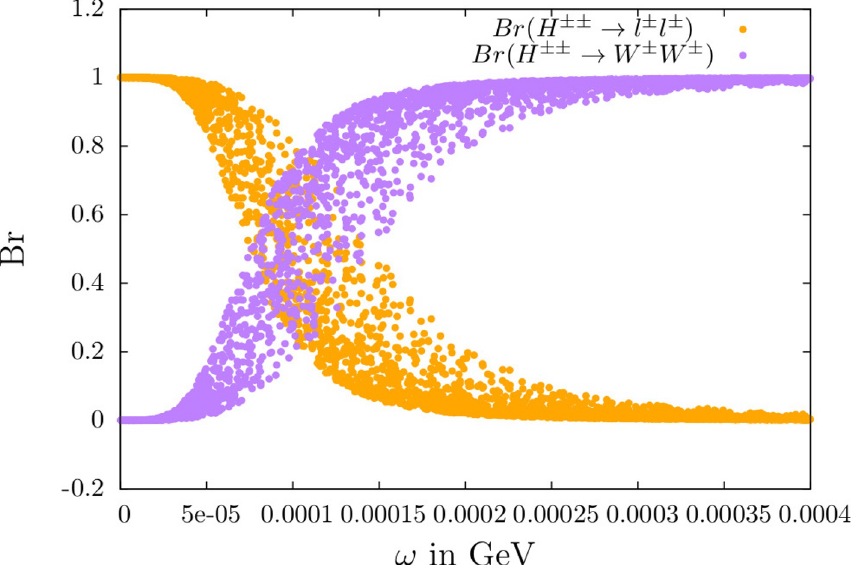
Figure 3 . Branching fractions of doubly-charged Higgs decaying into ‘ (cid:6) ‘ (cid:6) and W (cid:6) W (cid:6) channels as a function of triplet